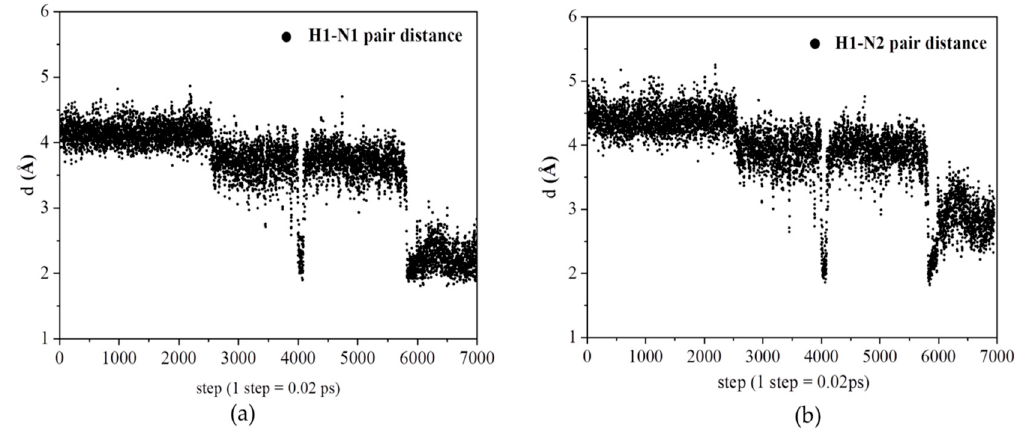
Figure 8. ( a ) The relative distance of a selected proton with N1 (N1 in Py). ( b ) The relative distance of a selected proton with N2 (N2 in Py).